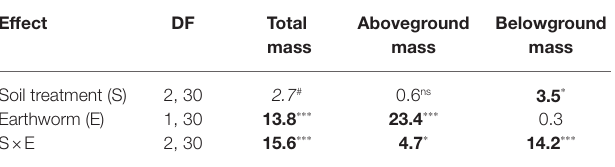
TABLE 1 | Results of ANOVAs for effects of soil treatment (homogeneous vs. heterogeneous small vs. heterogeneous large scale), earthworm (with vs. without) and their interactions on total, aboveground and belowground mass of Leymus chinensis at the whole pot level.